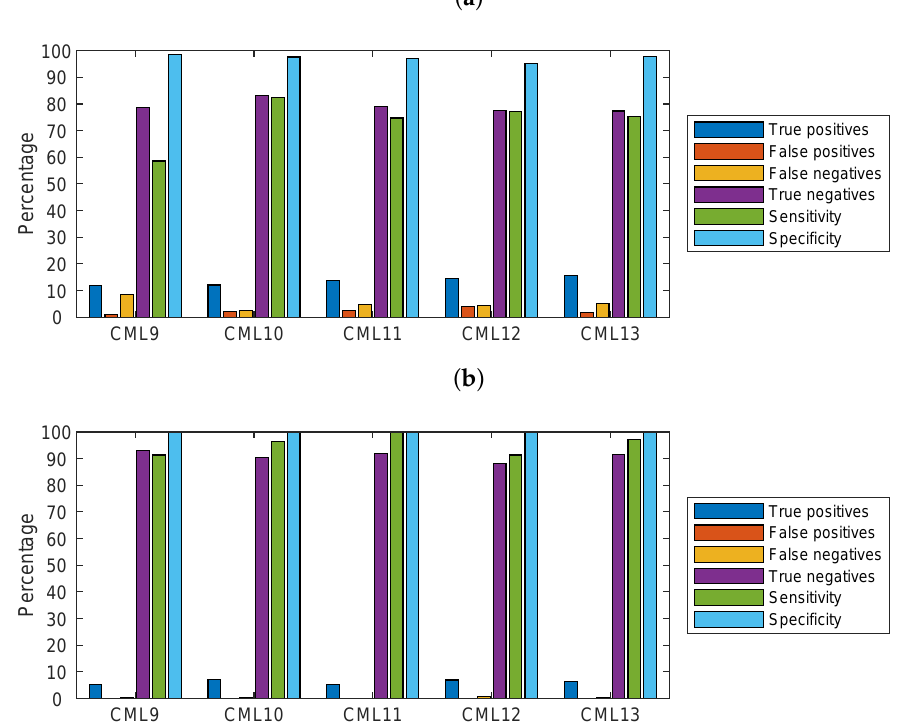
Figure 8. Contingency table, sensitivity, and specificity relative to the dry/wet classification algorithm based on CML: ( a ) all data, ( b ) only data with rainfall depth above R min (i.e., CML minimum detectable rainfall